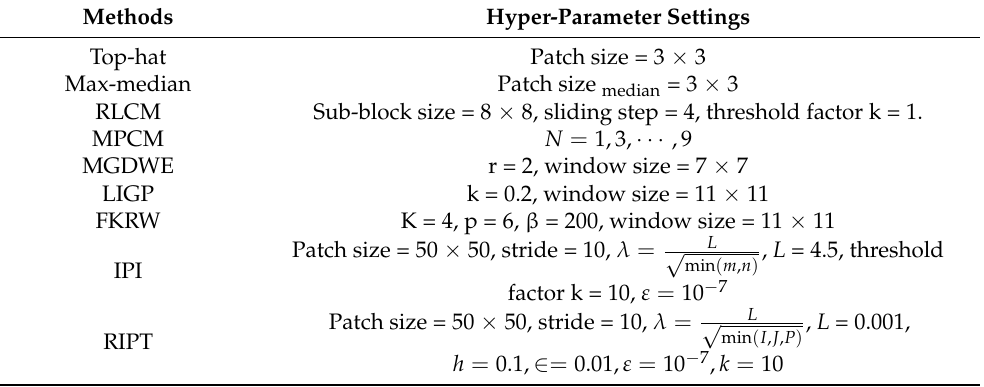
Table 2. Detailed hyper-parameter settings of traditional methods.